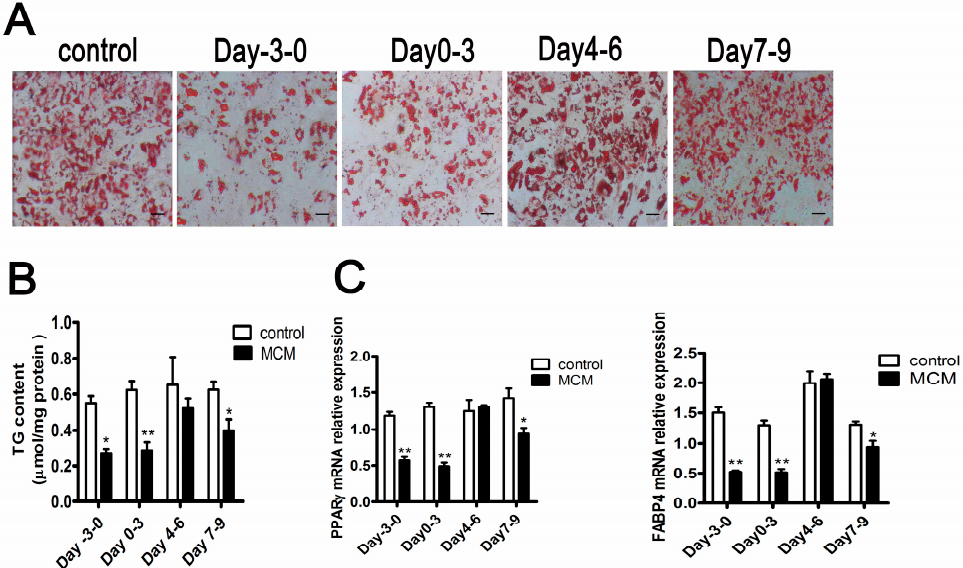
Figure 6. The effective duration of activity of MCM during adipocyte differentiation. s.c. preadipocytes were treated for three days with MCM at 120 µ g mL − 1 total protein concentration for four different time intervals: pre-differentiation (day –3 to 0), early (day 0 to 3), middle (day 4 to 6), and late (day 7 to 9) stages of differentiation. After nine days of differentiation, the effects of MCM on intracellular oil droplets ( A ) ( n = 3), triglycerides content ( B ) ( n = 3) and peroxisome proliferator-activated receptor γ ( PPAR γ ) and fatty acid binding protein ( FABP4 ) mRNA expression ( C ) ( n = 6) were verified. The mRNA expression differences were normalized to RPLP0 mRNA levels. Triglyceride content was normalized to protein content. * p < 0.05, ** p < 0.01, Scale bar = 200 μ m.